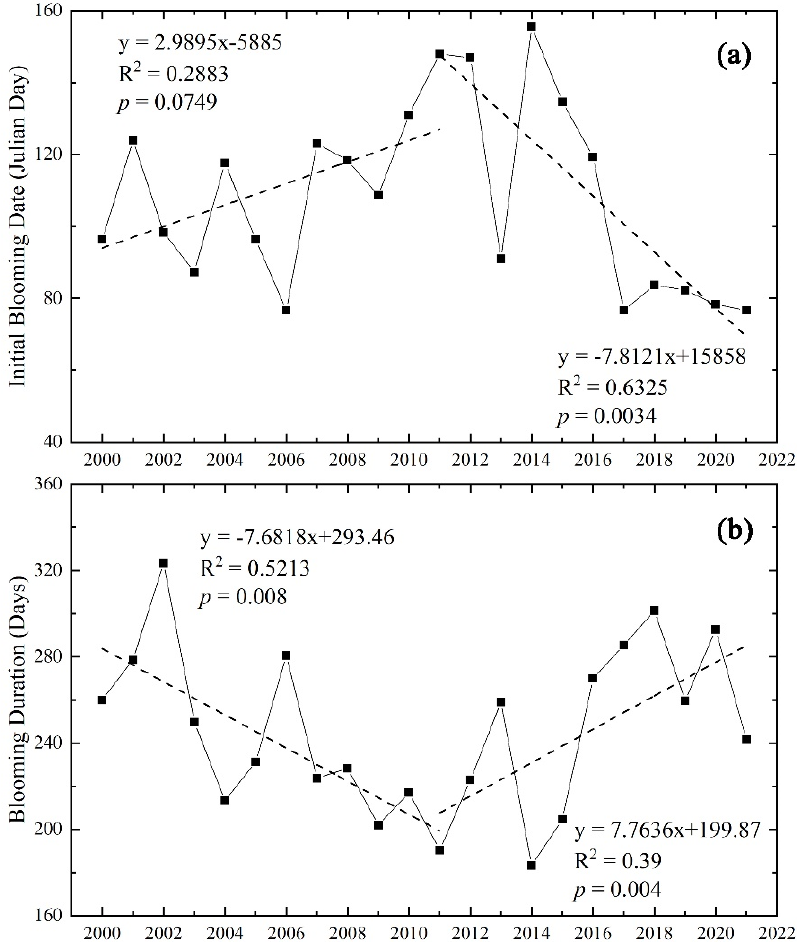
Figure 8. Trends in the initial bloom date and bloom duration for Lake Dianchi. ( a ) The initial bloom date throughout the time period of 2000–2021. ( b ) The bloom duration throughout the time period of 2000–2021.